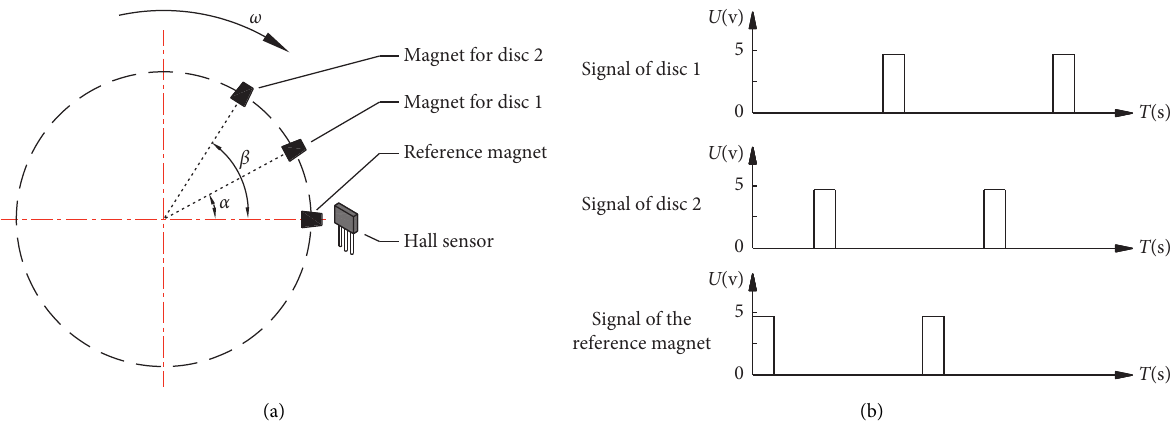
Figure 4: Principle of the position detection of the counterweight. Here, α and β represent the angle between the positioning magnet and the reference magnet of disc 1 and disc 2, respectively, in radians; ω represents the angular velocity of the rotating shaft, in radians per second; U represents the voltage output by sensors in volts; and T represents time in seconds.